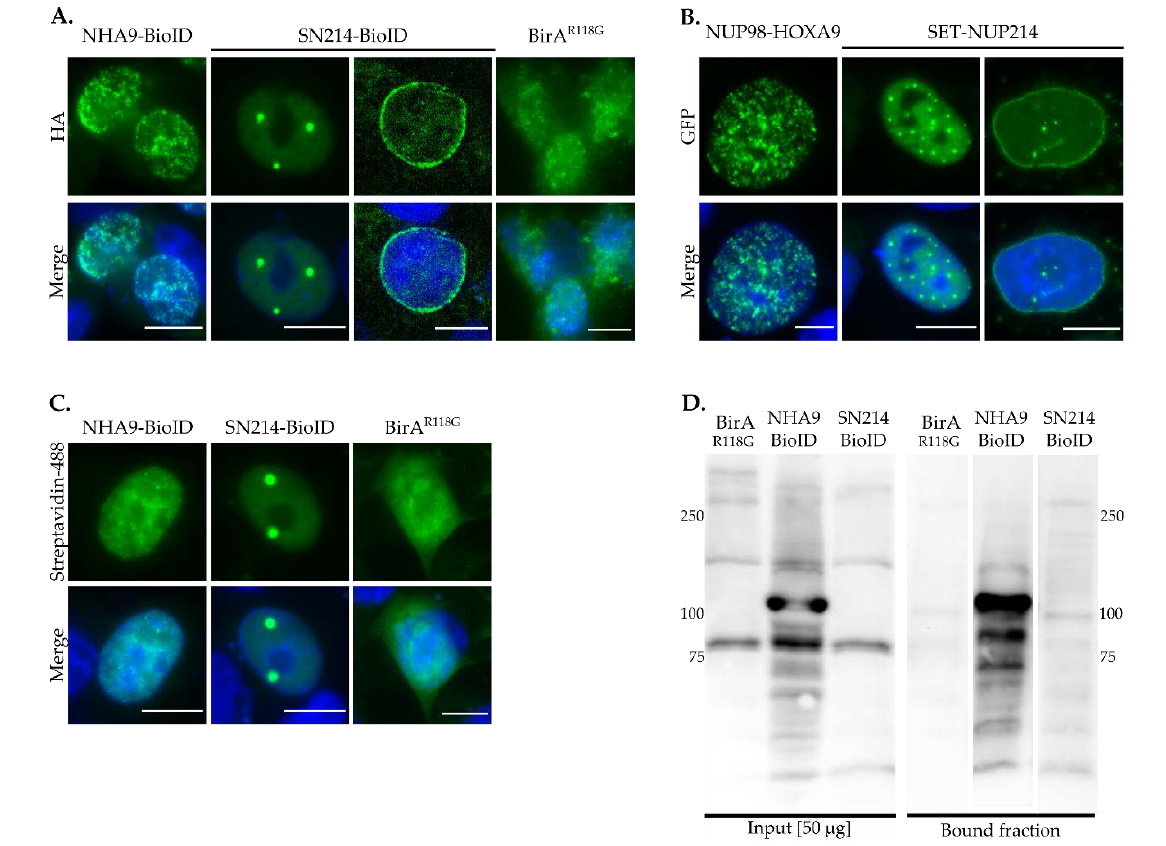
Figure 1. Proximity-dependent biotin identification (BioID) fusion protein expression and biotinylation of endogenous proteins. ( A ) Localization of NHA9-BioID, SN214-BioID, and BirA R118G was evaluated by immunostaining with anti-HA antibody. ( B ) Localization of GFP-tagged NUP98-HOXA9 and SET-NUP214 was evaluated by green fluorescent protein (GFP) fluorescence. NHA9-BioID and SN214-BioID exhibit the same distribution pattern in nuclear foci and at the nuclear envelope as their GFP-tagged counterparts. ( C ) Detection of protein biotinylation by Streptavidin-488. Cells were transfected with NHA9-BioID, SN214-BioID, and BirA R118G and probed with Streptavidin-Alexa Fluor ™ 488 conjugate. Shown are representative confocal images. DNA was visualized with DAPI (blue). Scale bars, 10 µ m. ( D ) For detection of protein biotinylation by NHA9-BioID, SN214-BioID, and BirA R118G , corresponding cell lysates were enriched on Streptavidin-coated magnetic beads and whole protein lysates and the bound fractions were analyzed by immunoblotting. Note, virtually no specific bands were detected in the bound fraction of BirA R118G , in contrast to the bound fractions of NHA9-BioID and SN214-BioID, which exhibited patterns of differentially biotinylated proteins.